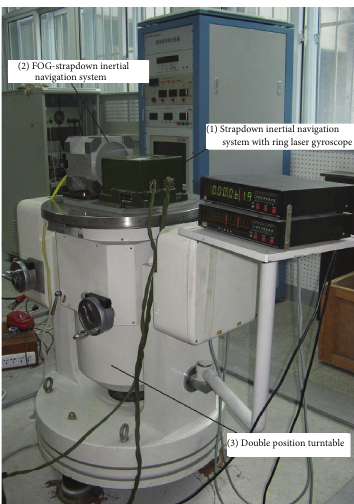
Figure 3: Experimental equipment installation